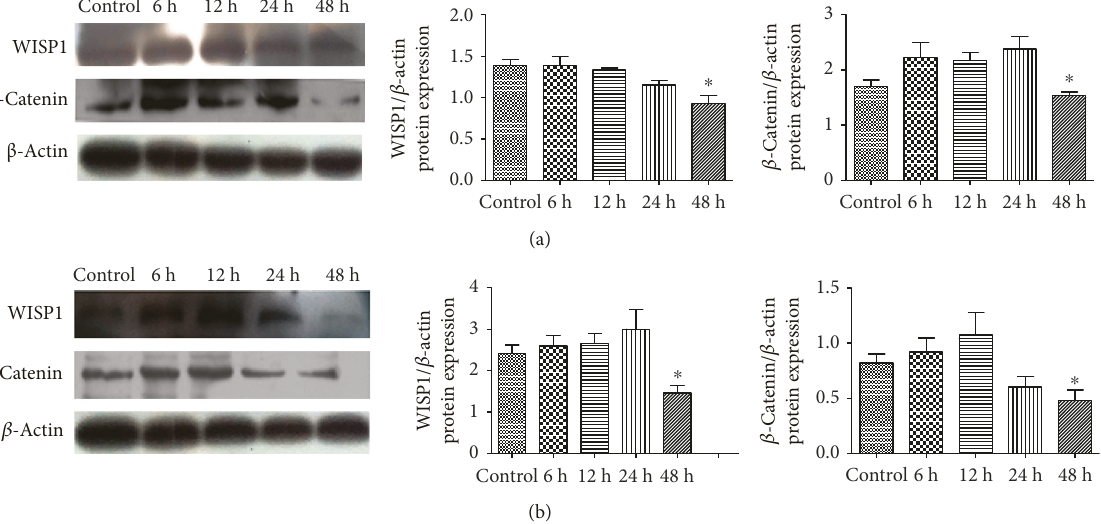
Figure 14: WISP1, β -catenin protein expression in PC12 cells, and SHSY5Y cells with the treatment of 50 μ Μ PQQ at di ff erent time. (a) Control: PC12 cells without PQQ; 6h, 12h, 24h, and 48h: di ff erent time points; (b) control: SHSY5Y cells without PQQ ( ∗ P < 0 05